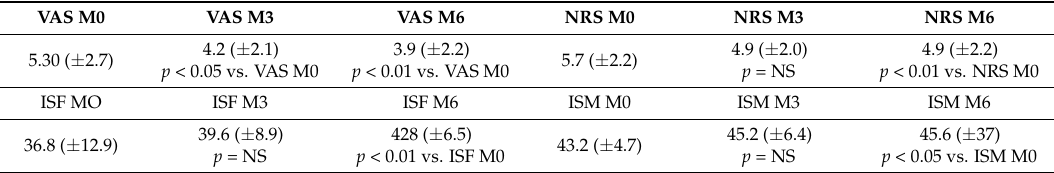
Table 2. VAS (visual analogue pain scale) and NRS (numerical rating pain scale pain scales) during the study.